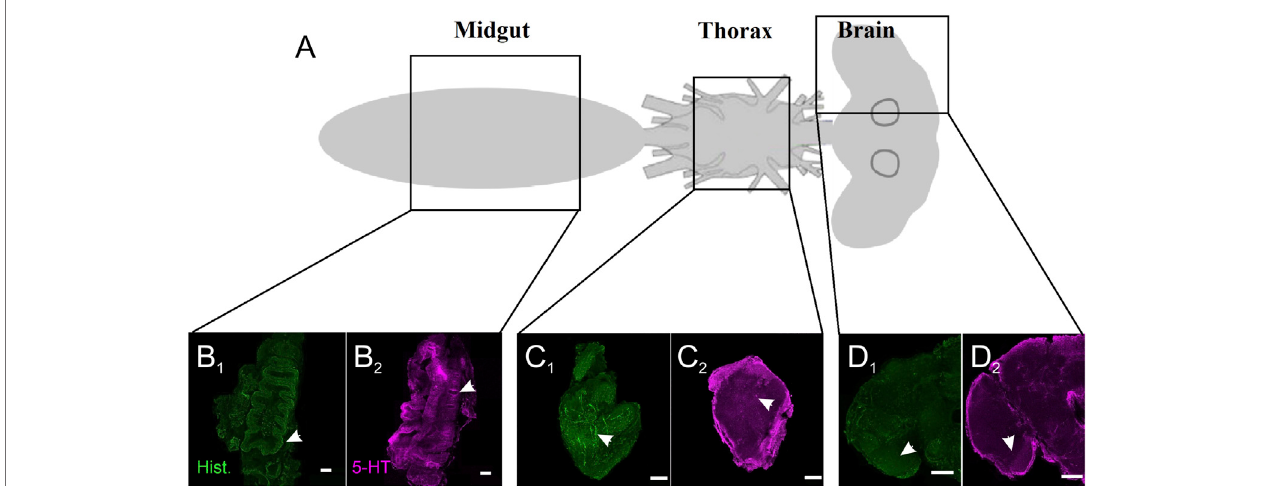
FIGURE 1 | Serotonergic and histaminergic innervation of A. stephensi tissues. (A) Schematic of the regions for immunohistochemistry. (B) Staining of the midgut for histamine (B 1 ) and 5-HT (B 2 ) . Arrows denote the differences in staining for the lining of the midgut. (C) Staining of the thoracic ganglion for histamine (C 1 ) and 5-HT (C 2 ) . Arrows denote blebby-like staining. (D) Staining of the brain for histamine (D 1 ) and 5-HT (D 2 ) . Arrows denote stronger staining in the optic lobes for histamine and